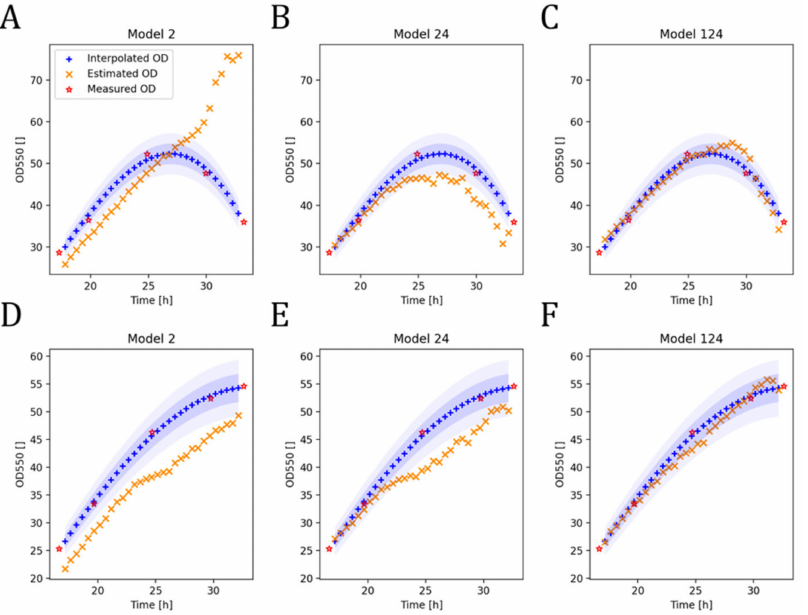
Figure 3. Progression of the generalized model estimates based on two examples of strain 3 ( A – C ) and ( D – F